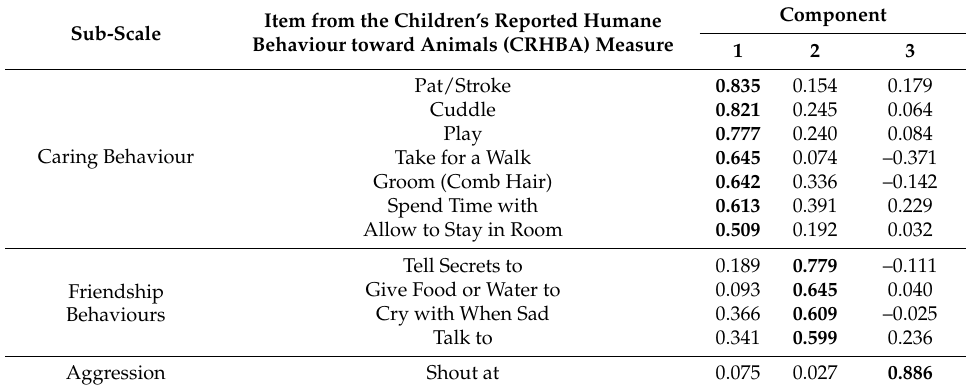
Table 1. Principal component analysis with varimax rotation showing variable loadings on each component extracted from analyses ( N = 1217). High loadings are in